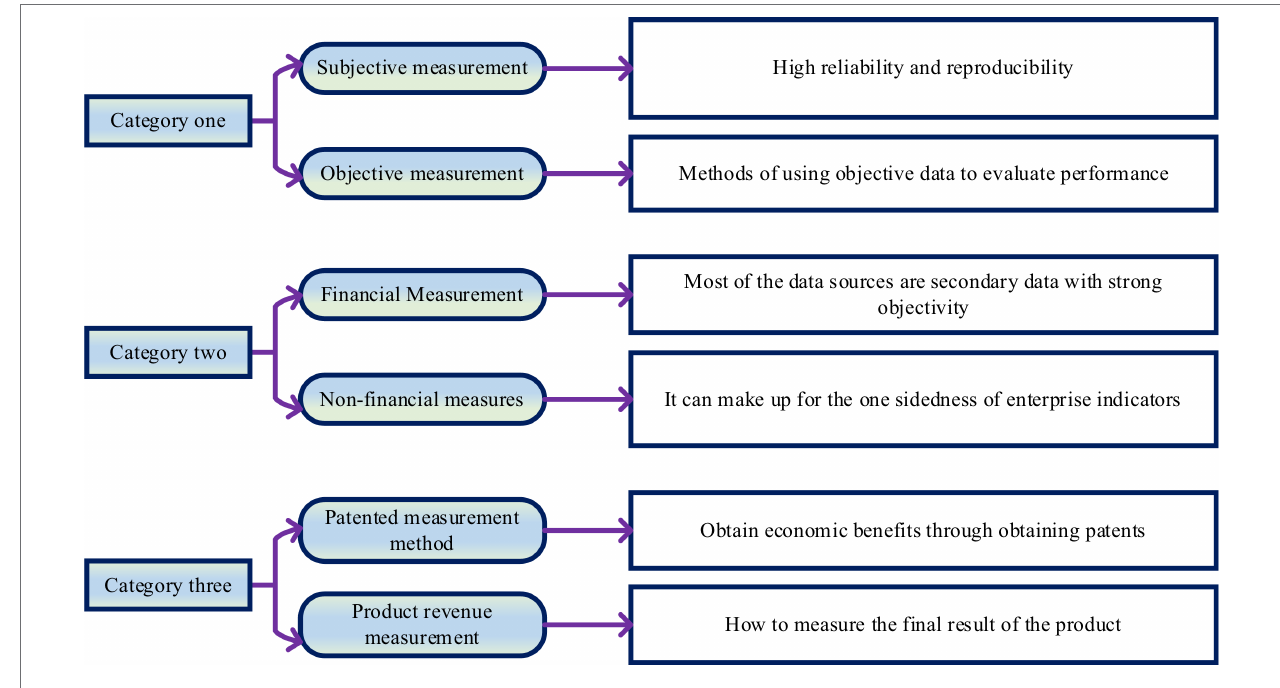
FIGURE 3 | The specific meaning of each measurement